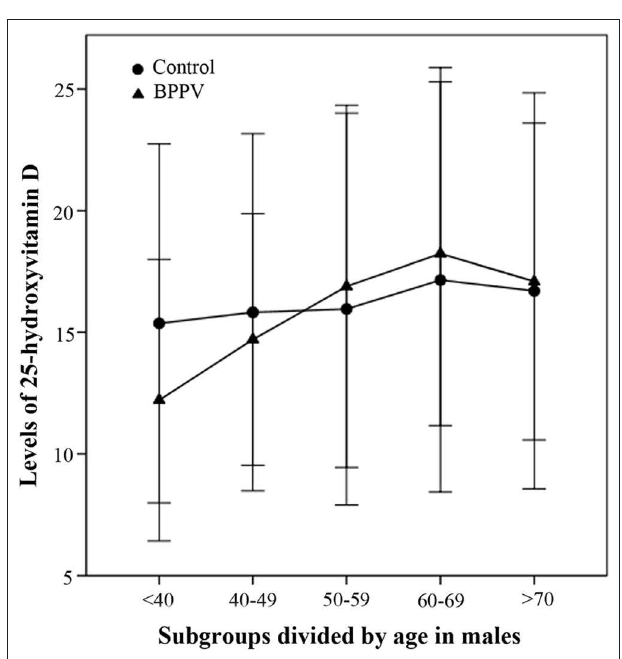
FIGURE 3 | Comparison of male 25-hydroxyvitamin D levels between the BPPV and control subgroups divided by age. The median levels of 25(OH)D levels in subgroups divided by age are indicated by black circles in the control group and by black triangles in the BPPV group. Error bars show standard